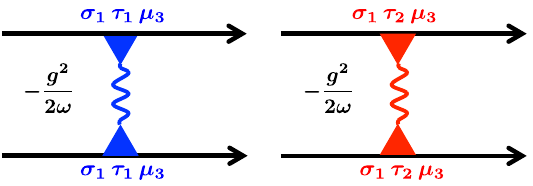
FIG. 13. Phonon-mediated attraction. The two scattering channels corresponds to the two phonons and have the same amplitude g 2 = 2 ω .